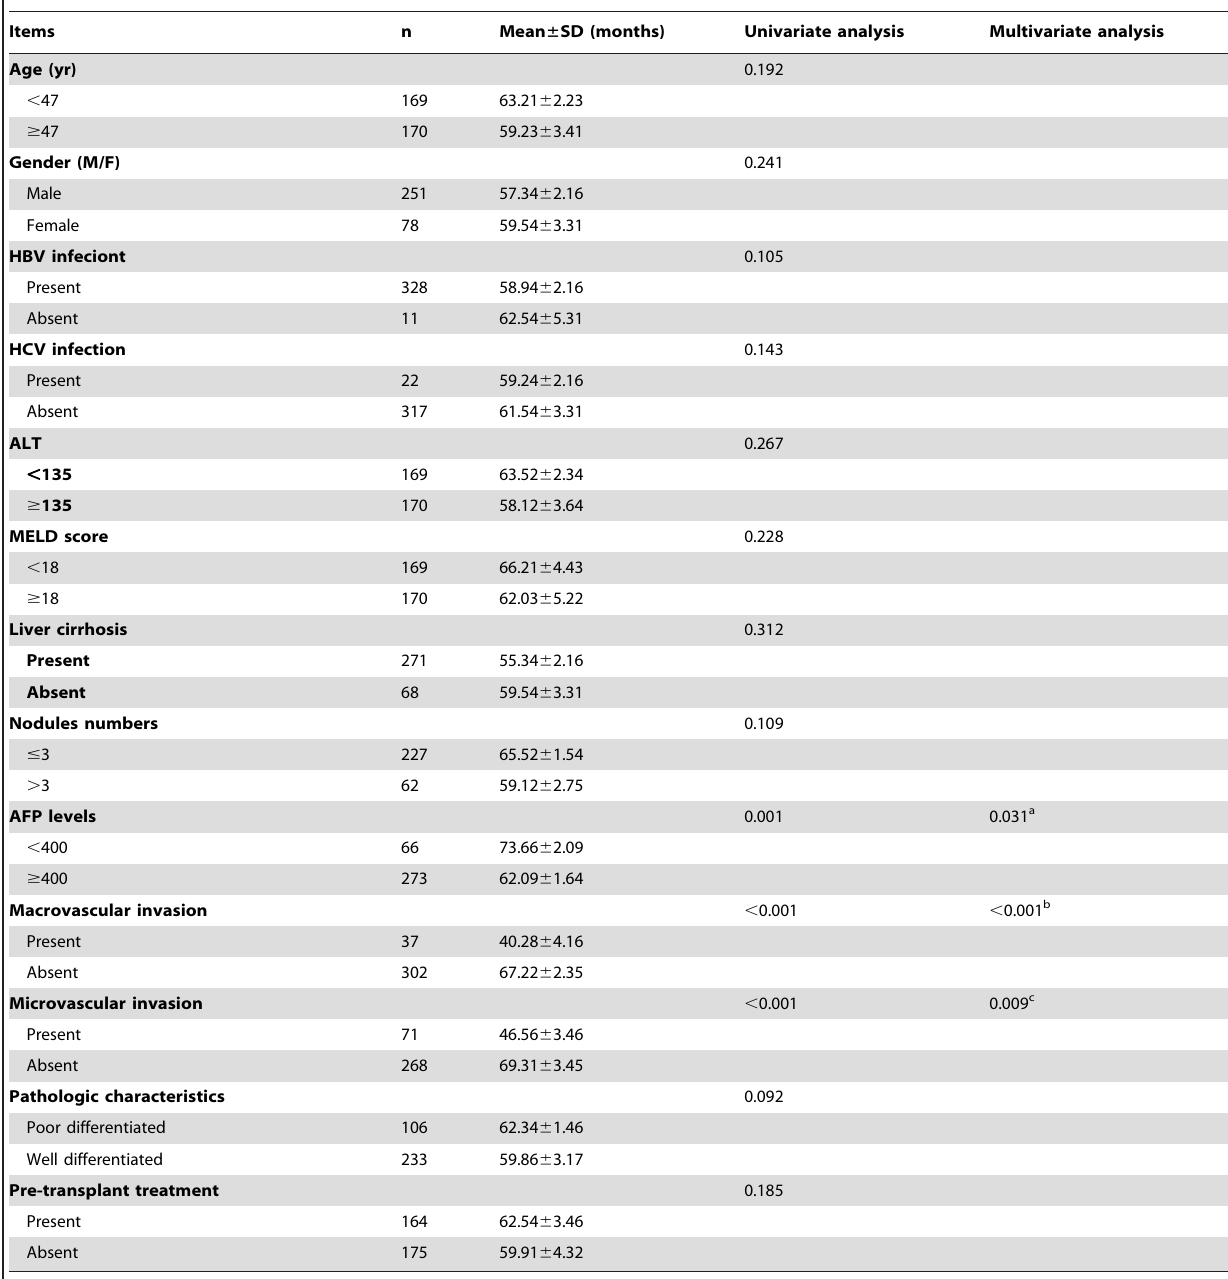
Table 4. Risk factors for Overall survival of liver transplantation by Multivariate